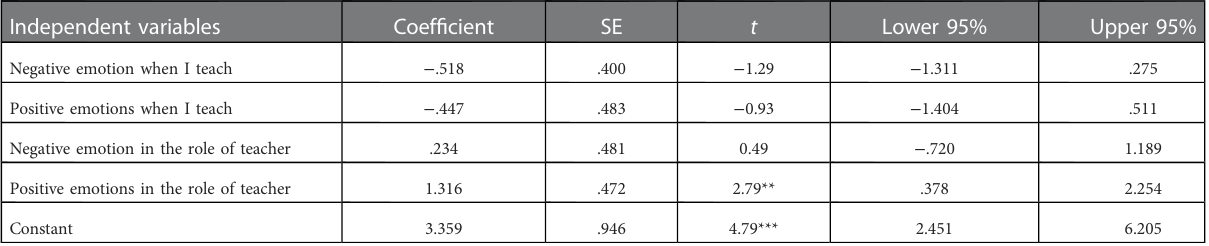
TABLE 4 Multivariate regression analyses testing the in fl uence of emotions on self-perceived instructional ef fi cacy ( n =104). Independent